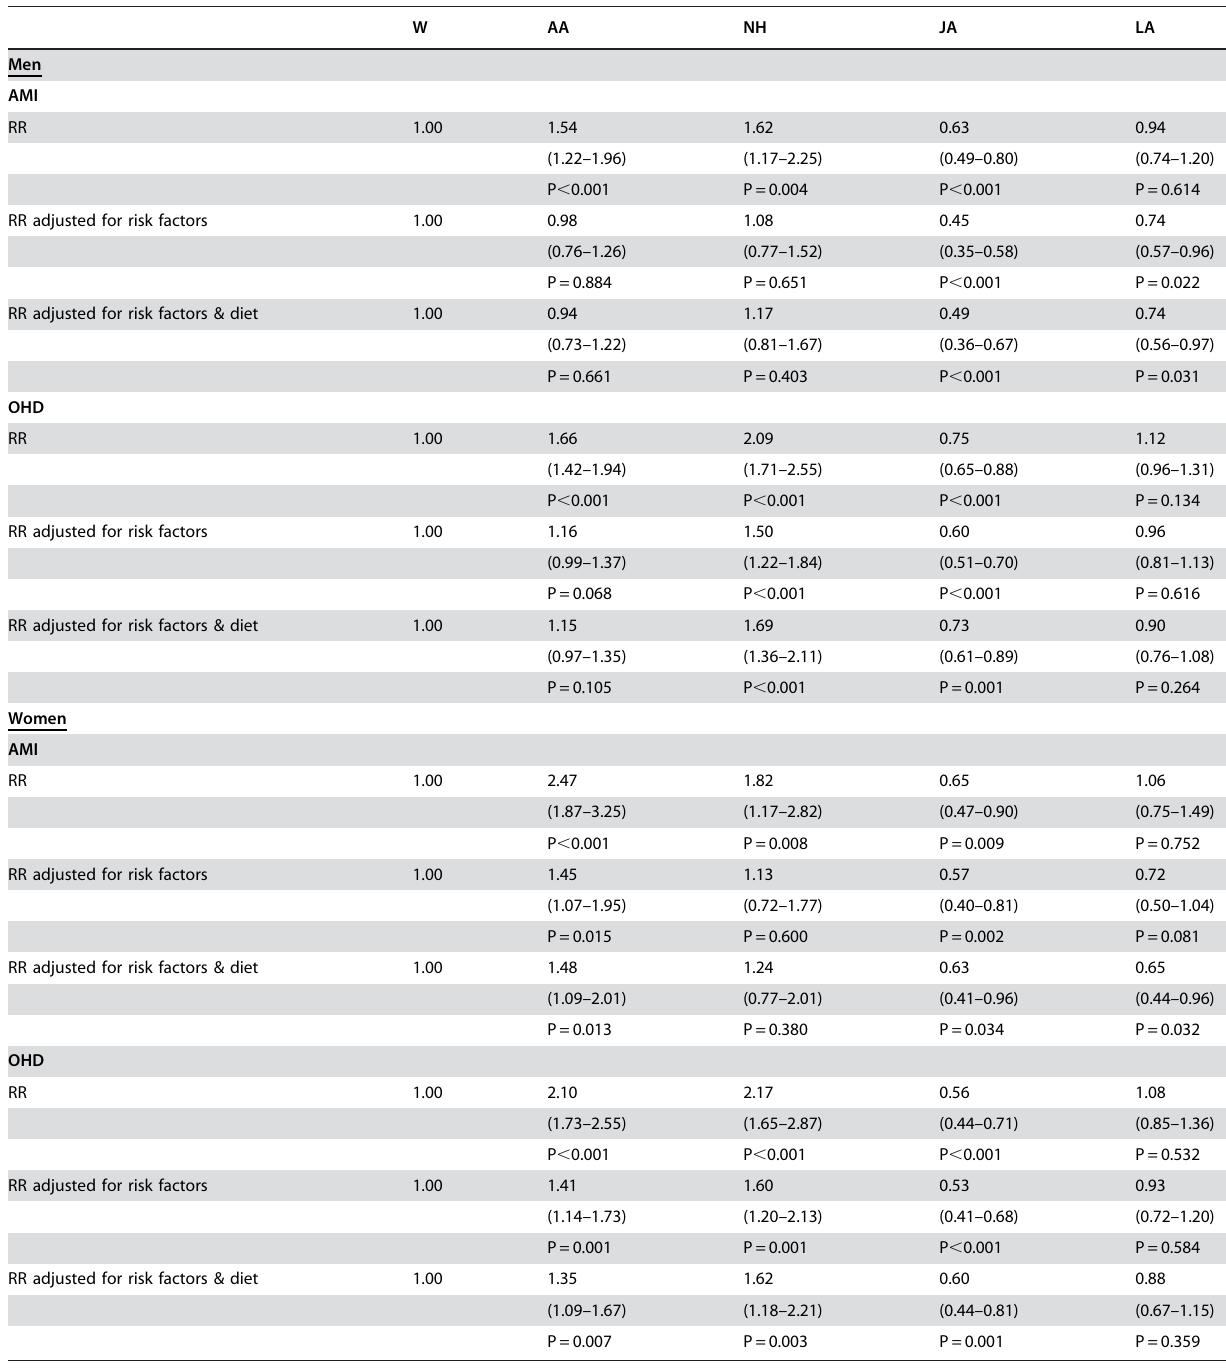
Table 4. Observed and adjusted rate ratios (RRs) of death from AMI and OHD by race and gender in the MEC. .. ... .... ... ... .... ... ... .... ... ... .... ... ... .... ... ... .... ... ... .... ... ... .... ... ... .... ... ... .... ... ... .... ... ... .... ... ... .... ... ... .... ... ... . W AA NH JA